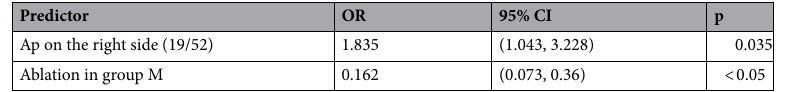
Table 4. Stepwise multivariate Cox proportional hazards model: